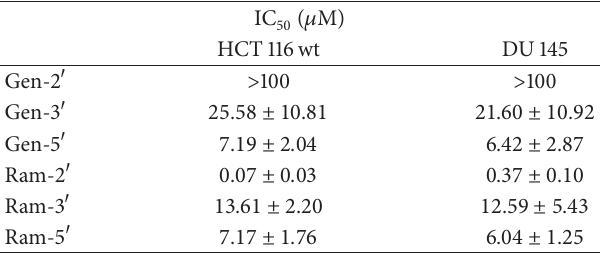
Table 1: IC value of proliferation inhibition calculated on the base 50 of MTT